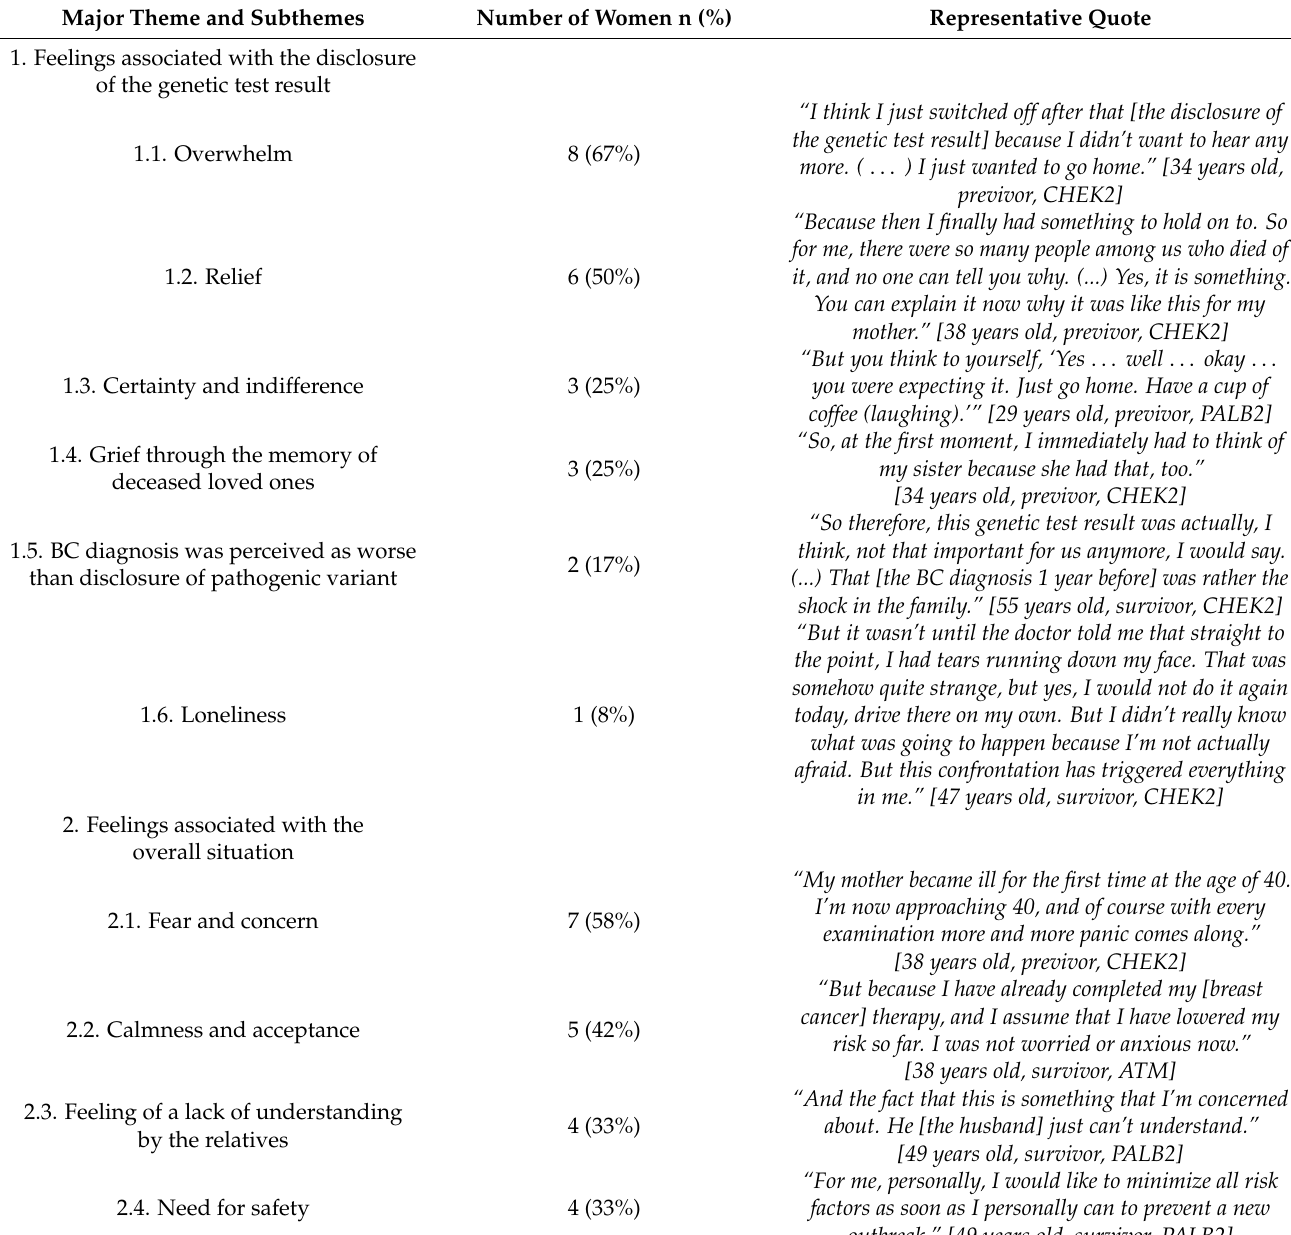
Table 2. Major themes that emerged from the data and representative